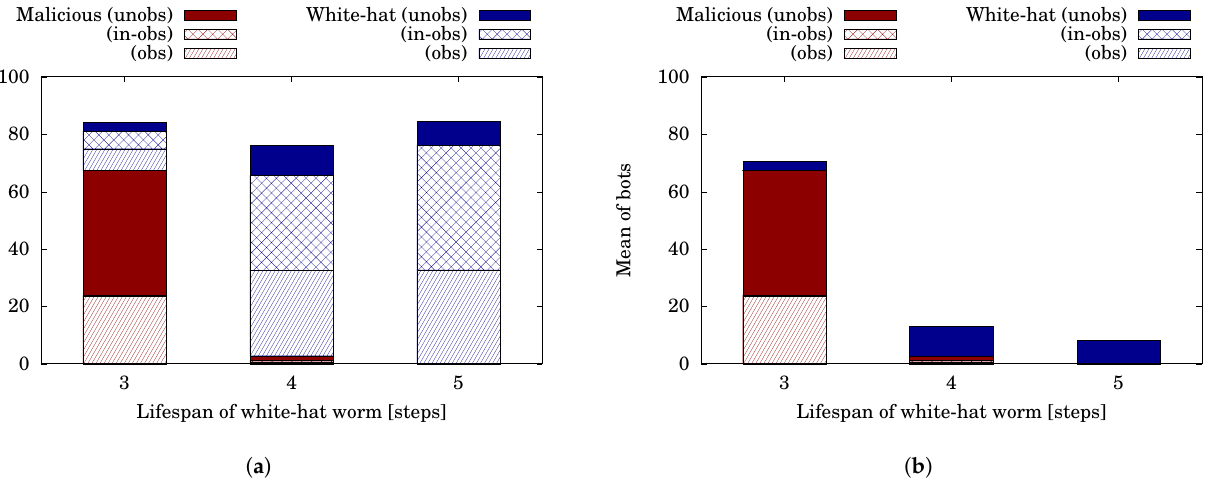
Figure 10. Simulation results in the hierarchical case. ( a ) Before Withdrawal (10,000 − steps); ( b ) After Withdrawal (10,000 +